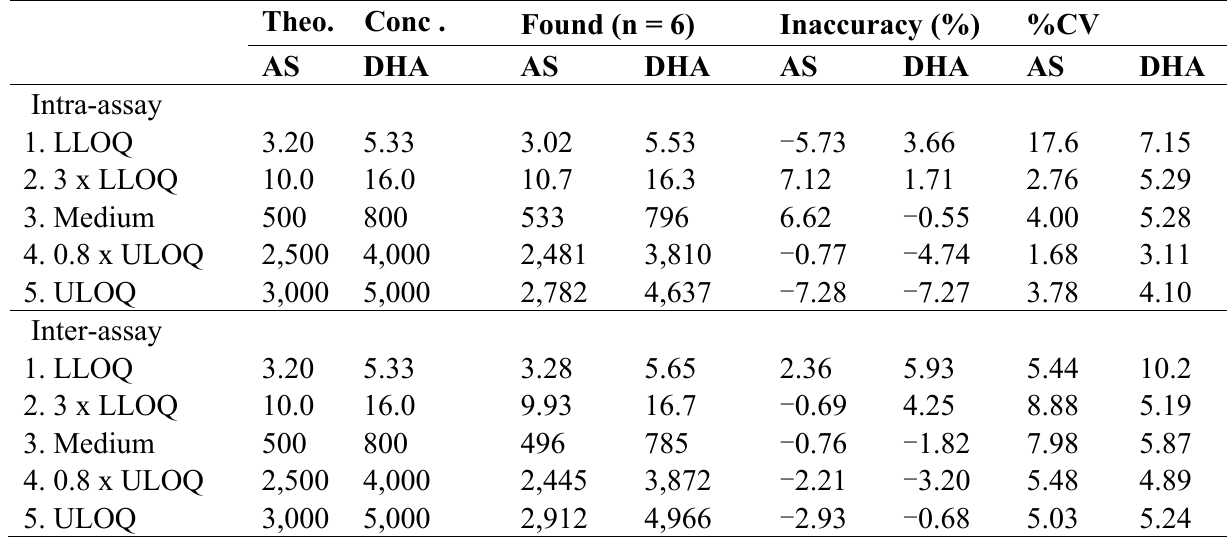
Table 1 . Intra-assay and inter-assay accuracy and precision tests for AS and DHA in human plasma. Theo. Conc . Found (n = 6) AS DHA